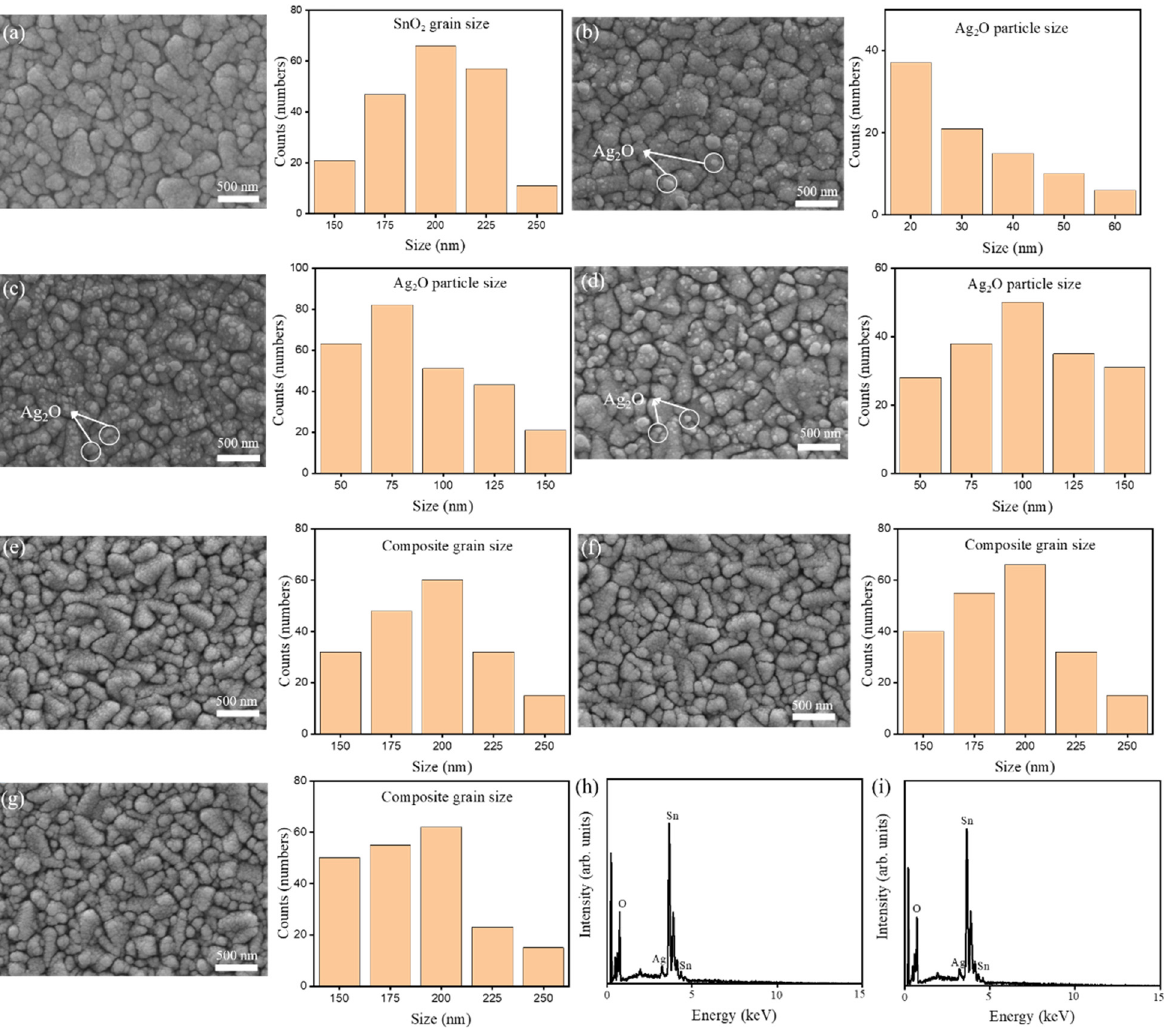
Figure 2: SEM top view images: ( a ) pristine SnO 2 , ( b ) SA130, ( c ) SA200, ( d ) SA270, ( e ) CSA130, ( f ) CSA200, and ( g ) CSA270. The corresponding SnO 2 surface grain size, Ag 2 O particle size, and composite fi lm surface grain size distribution histograms are also shown in the insets. The representative EDS spectra of Sn, Ag, and O elements taken from the composite fi lms: ( h ) SA200 and ( i )